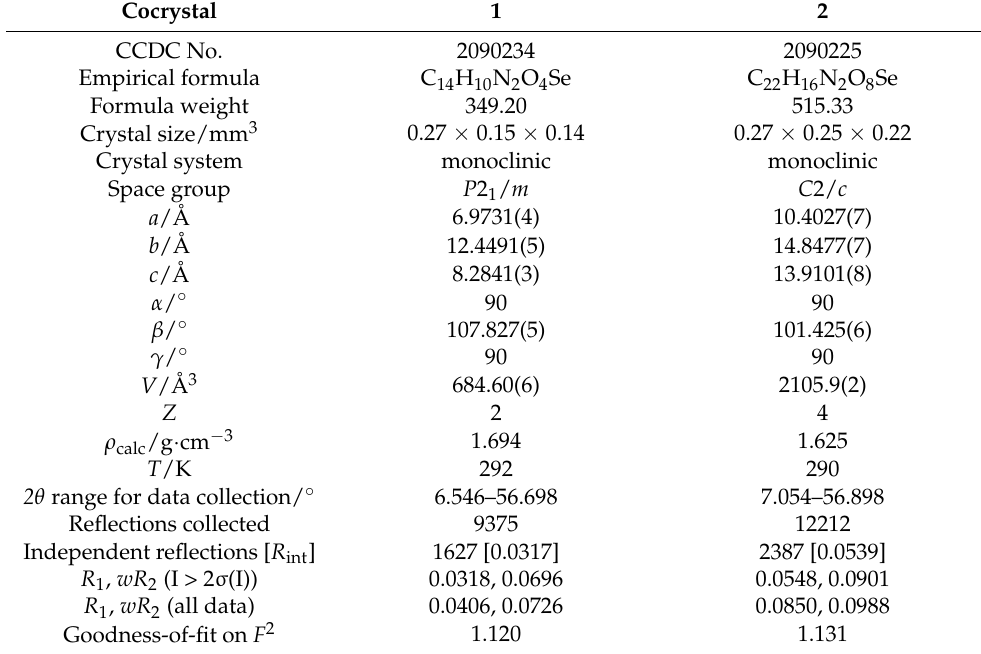
Table 1. Crystallographic data and structure refinement parameters for cocrystals 1 and 2